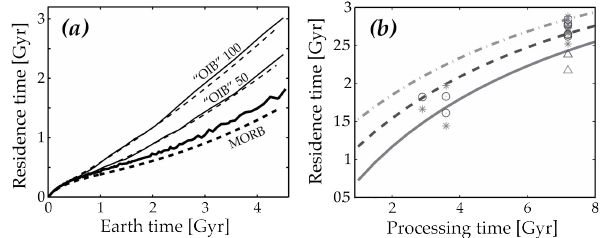
Fig. 8. (a) Residence times from MORB and “OIB” samples of three-dimensional models (solid curves). Dashed curves are esti- mates based on the sampling theory (Sect. 3.9). “OIB” 50 is for an excess density of 50kgm − 3 , “OIB” 100 is for 100kgm − 3 . (The “OIB” interpretation is discussed below.) (b) Final residence time as a function of processing time, τ . Curves are from the sam- pling theory (Sect. 3.9) for simple sampling (solid) and two cases in which a sampling delay has been assumed (400Myr, dashed; 1.2Gyr, dash-dot). Results from various numerical models are in- dicated by the symbols. From Huang and Davies (2007b, a). Copy- right American Geophysical Union.